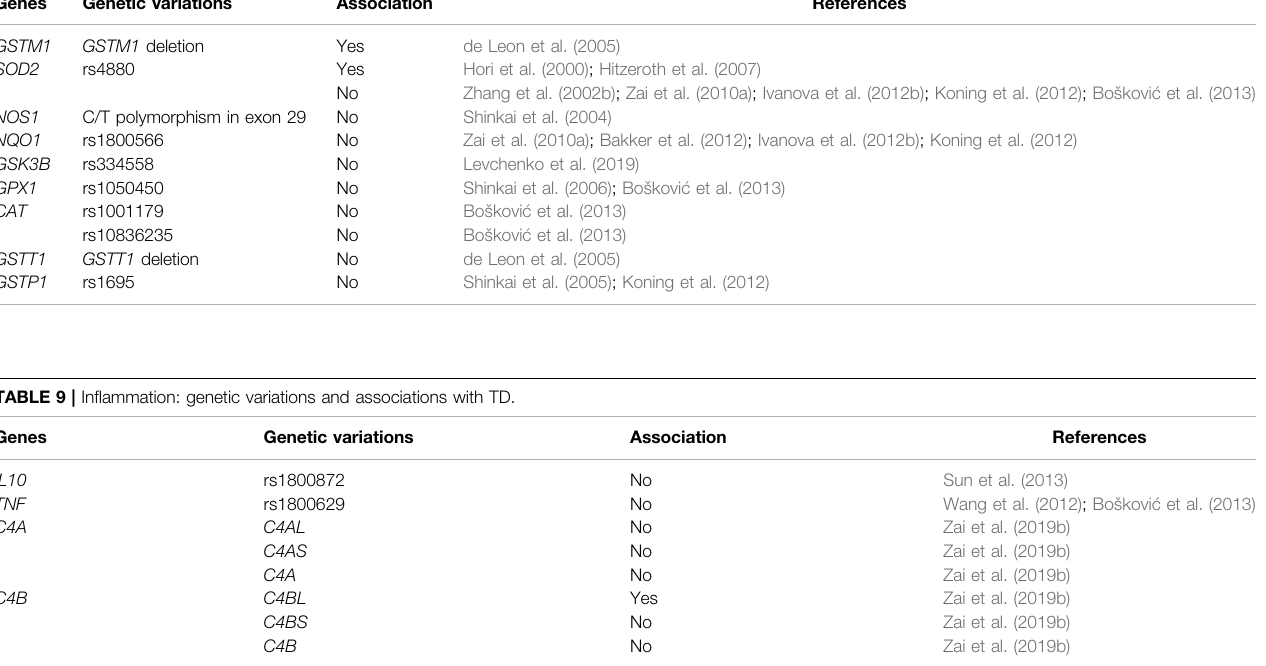
TABLE 8 | Oxidative stress pathway: genetic variations and associations with TD. Genes Genetic variations